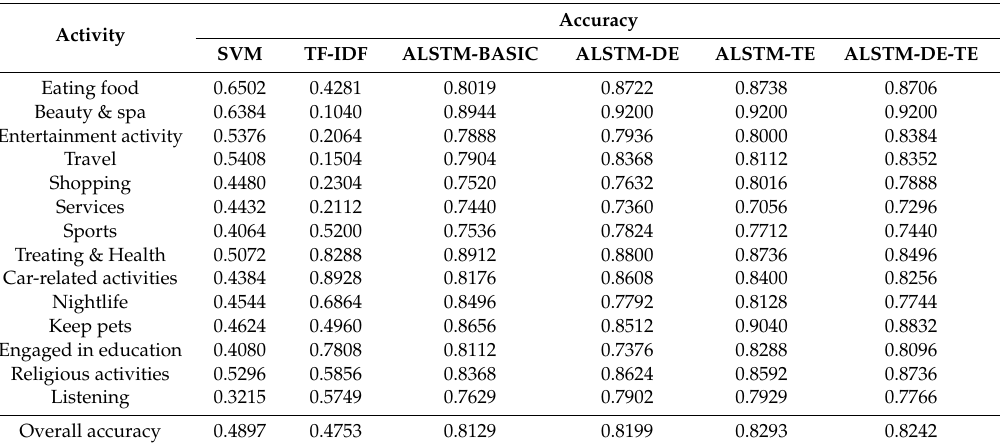
Table 5. Overall